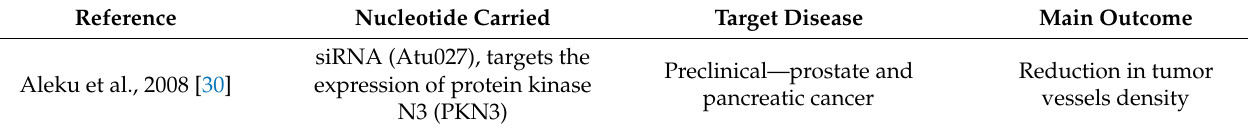
Table 1. Liposomes for the delivery of nucleic acids in cancer